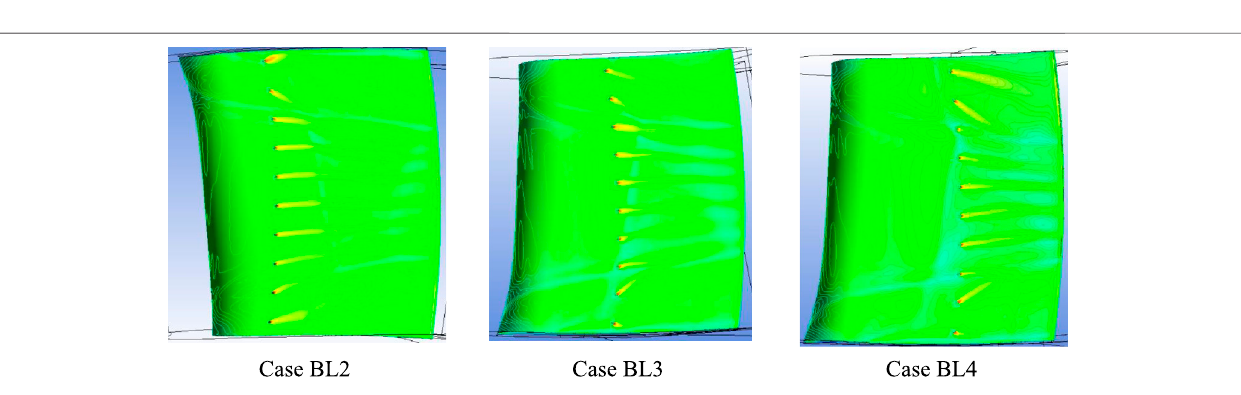
FIGURE 6 | Adiabatic fi lm cooling effectiveness η contours of low-degree-of-reaction (DOR) blade airfoil.